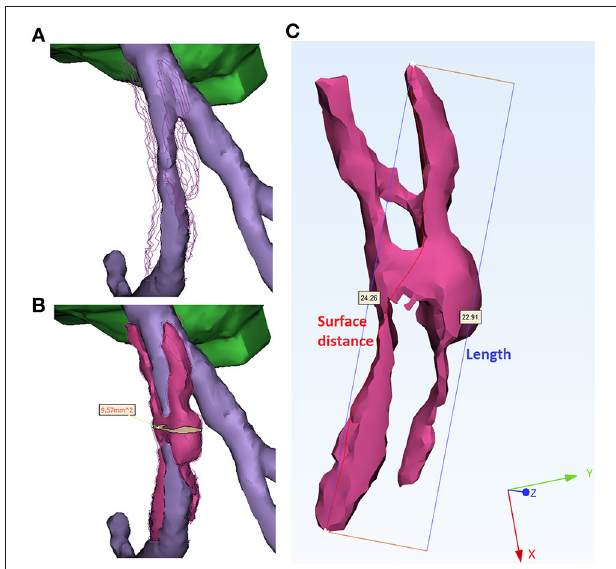
FIGURE 3 | Measurement of geometric parameters. (A) Stenosed artery lumen. The surface of plaque was indicated by polylines for better comparison. (B) Measurement of the cross-section area of a plaque (magenta). The cross-section with the maximal area (yellow) was derived perpendicularly to the centerline of arterial segment (purple). (C) Measurement of length and surface distance of a plaque. The red curve (24.26mm) and blue segment (22.91mm) illustrate the shortest distance on the surface and in the 3D space, respectively.